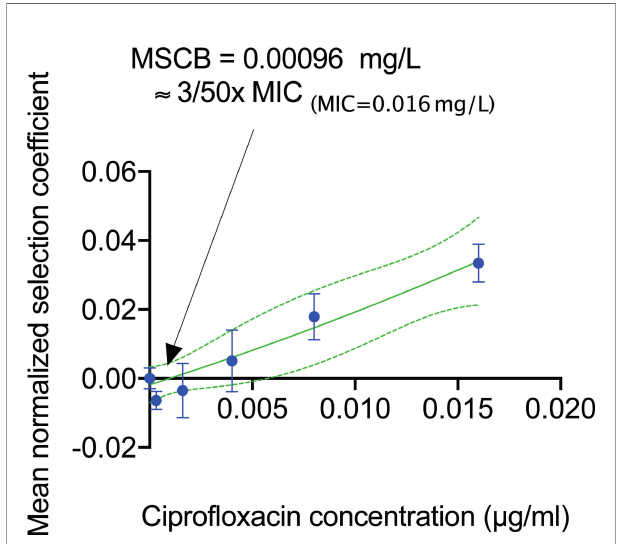
FIGURE 6 | Determination of the minimal selection concentration of cipro fl oxacin in bio fi lms. Mean selection coef fi cients (blue dots) fi tted with a second-degree polynomial fi t (indicated as a green line and 95% CI indicated in dashed green lines) as a function of cipro fl oxacin concentration determined from direct competitions of mixed strains of cipro fl oxacin susceptible and gyrA (S83L) cipro fl oxacin resistance E. coli MG1655 in a 16 h bio fi lm formation experiments. The minimal bio fi lm selection concentration (MSCB) was calculated to 0.00096 mg/L. All error bars represent